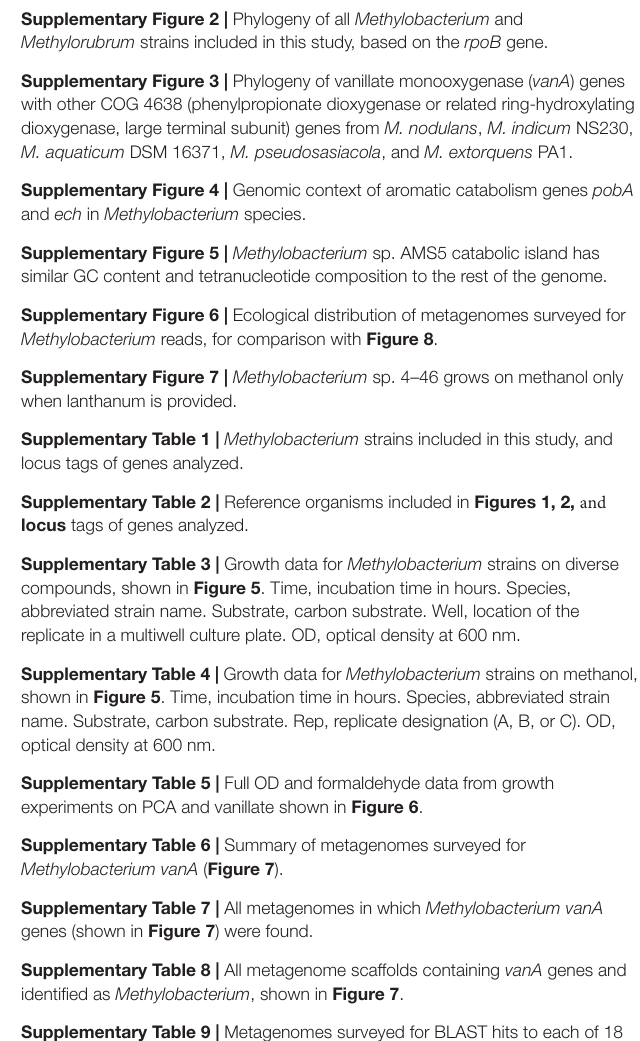
Frontiers in Microbiology |